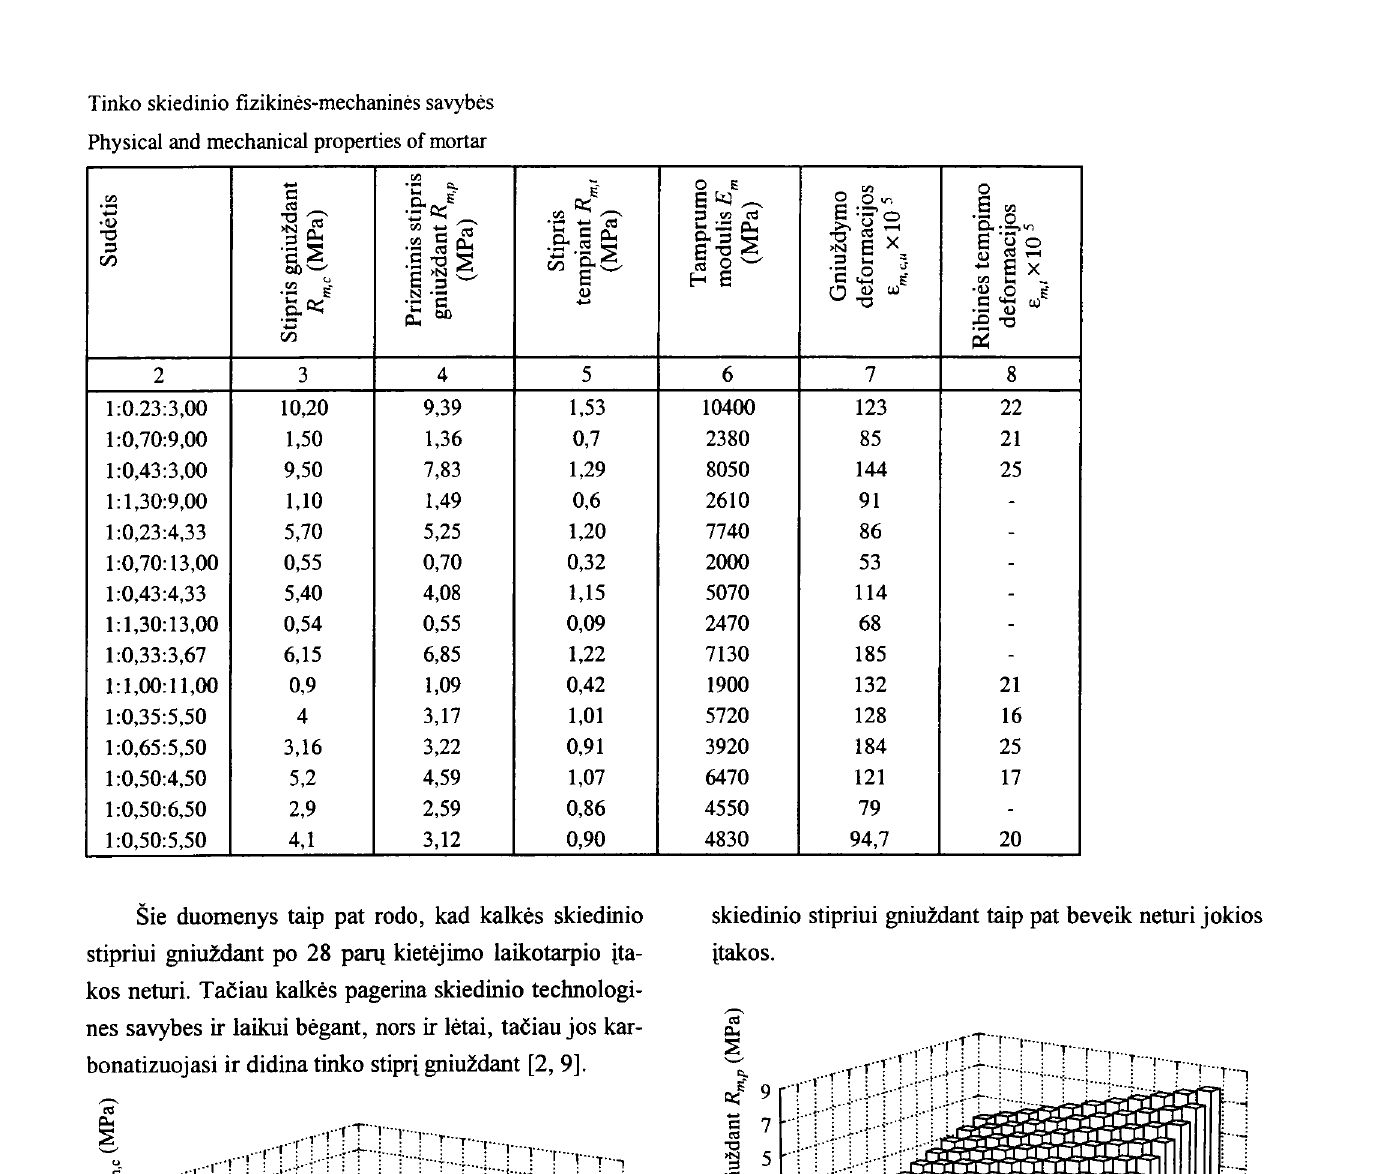
3 pav. Skiedinio prizminio stiprio priklausomybes nuo smelio ir cemento kiekio tiirio dalimis Fig 3. Relationship between compressive prism strength of mortar and volume parts of cement and sand Palyginus I ir 2 lygtis, taip pat 3 ir 4 paveiksl~t matyti, kad kubelinio ir prizminio stiprio priklausomy bes panasios. Palyginus skiedinio Rm.c ir Rm,p gauta, kad vidutiniskai Rm.p=0,83Rm.c· Pana5ios priklausomybes tarp betono kubelinio R ir prizminio stiprio Rb yra gau tos daugelio ivairi4